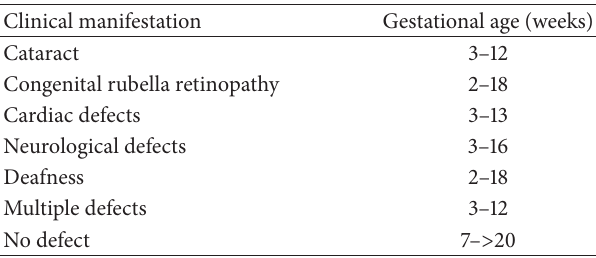
Table 1: Gestational age at time of confirmed rubella in pregnancy and clinical manifestations of congenital rubella syndrome